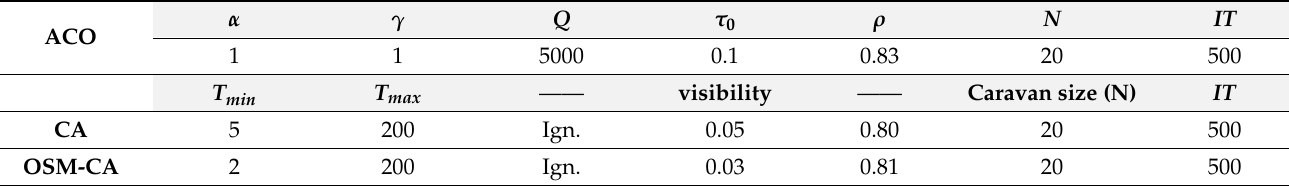
Table 15. Tuned algorithm parameters.